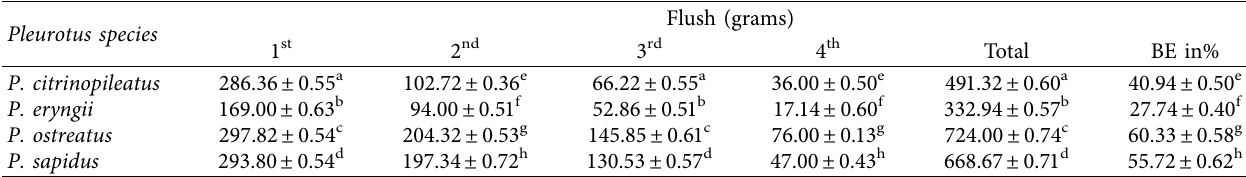
Table 6: Yield and biological efficiency of the four Pleurotus species on composted coffee husks substrate. Pleurotus